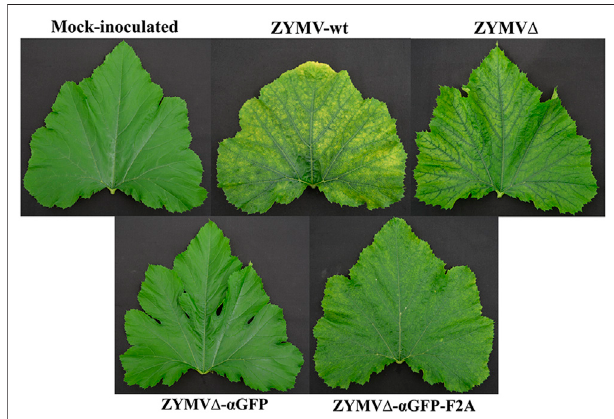
FIGURE 2 | Pictures of representative upper leaves from zucchini plants mock-inoculated and agroinoculated with ZYMV-wt, ZYMV Δ , ZYMV Δ - α GFP, and ZYMV Δ - α GFP-F2A, as indicated, taken at 21